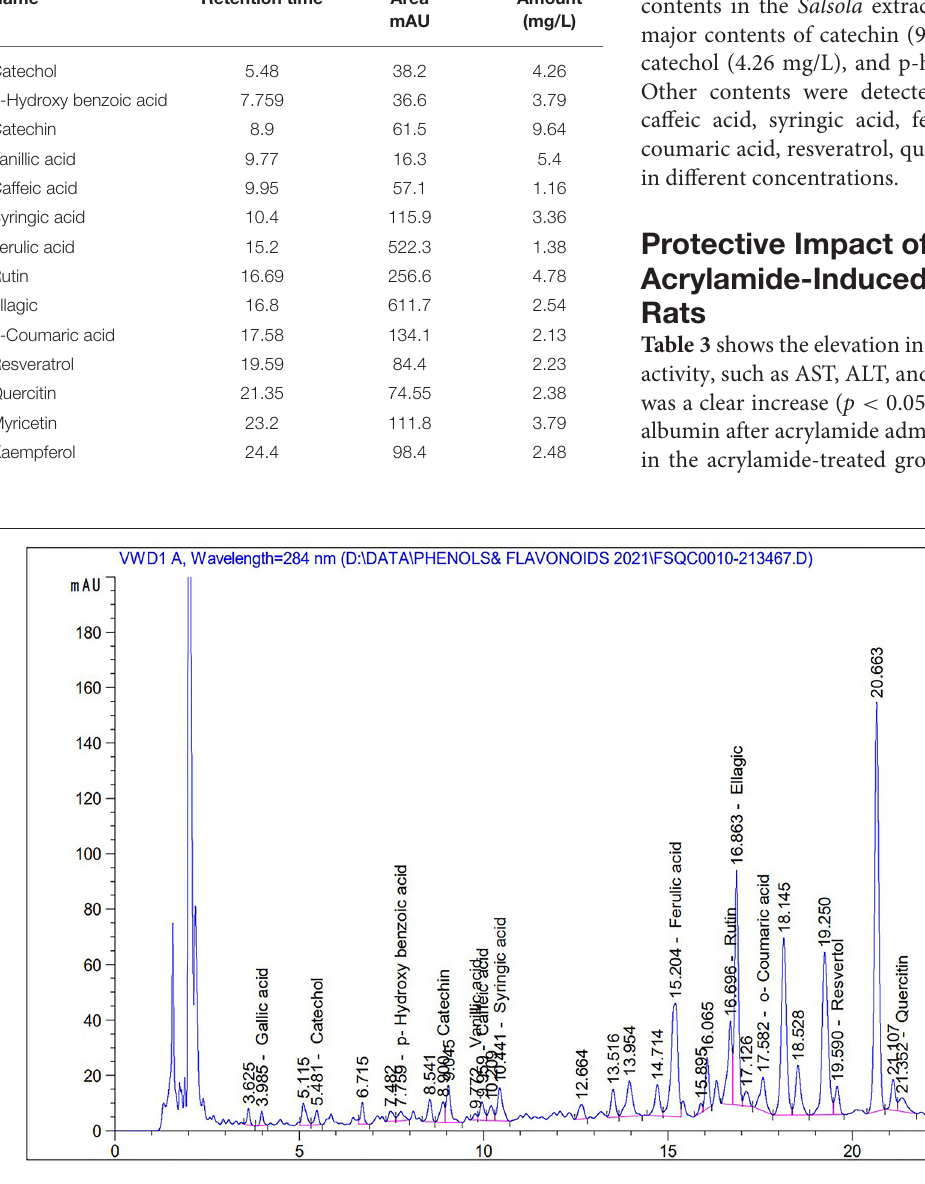
Frontiers in Veterinary Science |